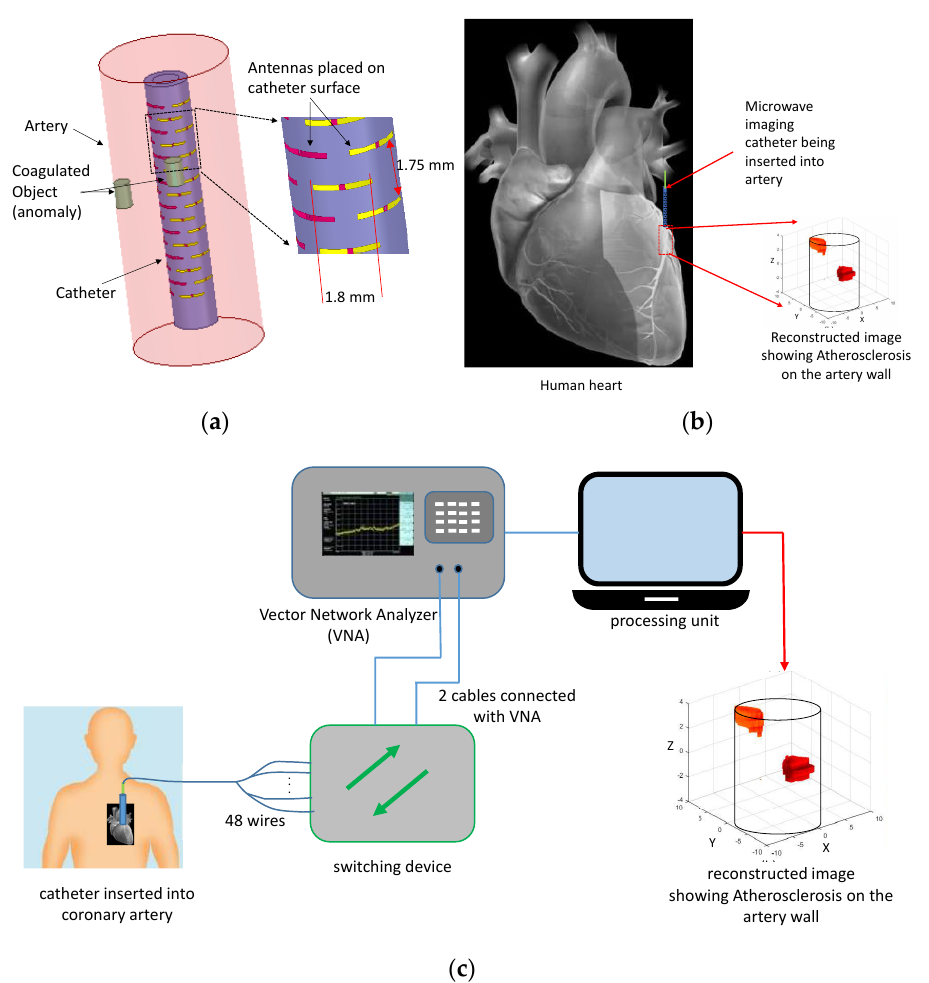
Figure 1. ( a ) The imaging catheter placed inside the coronary artery model, ( b ) overview of the imaging process, ( c ) envisioned block diagram of the complete system performing the imaging.